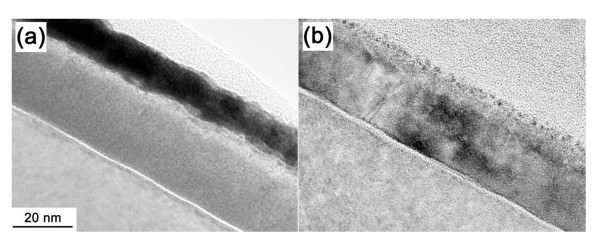
Cross-sectional TEM images of TiO2/ZrO2/Si thin films. (a) As-deposited and (b) annealed at 773 K.